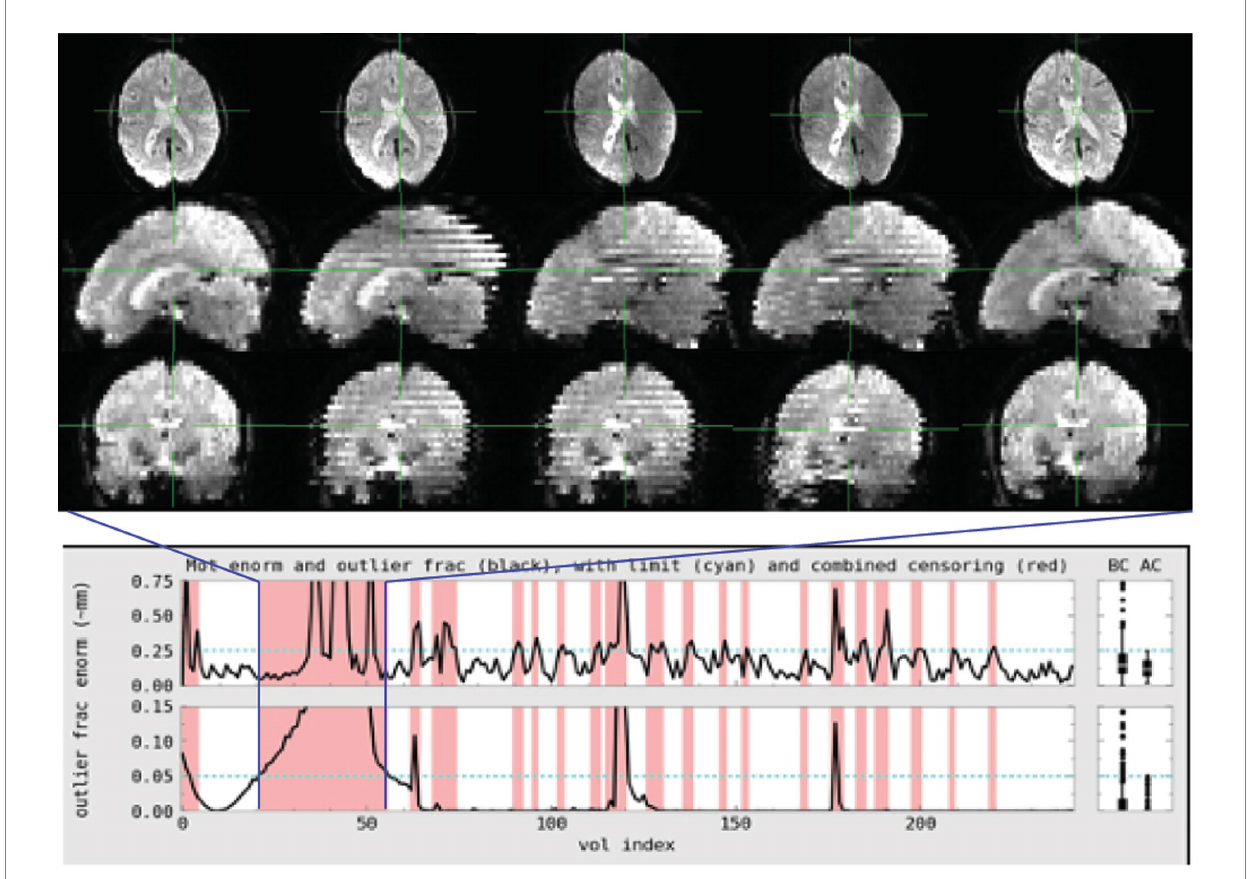
FIGURE 1 Subject 017 had a high number of censored volumes due to motion. This figure depicts several volumes in which the motion artifact is very clear. Banding due to the magnitude of head motion during acquisition are visible on the sagittal and coronal slices. Within the axial slice, this motion makes part of the lateral ventricles disappear because of displacement during acquisition. Such a large motion artifact should be visible on the console even in an axial-only view. Operationally, it would be useful to note this during acquisition and consider collecting an additional run while the subject is